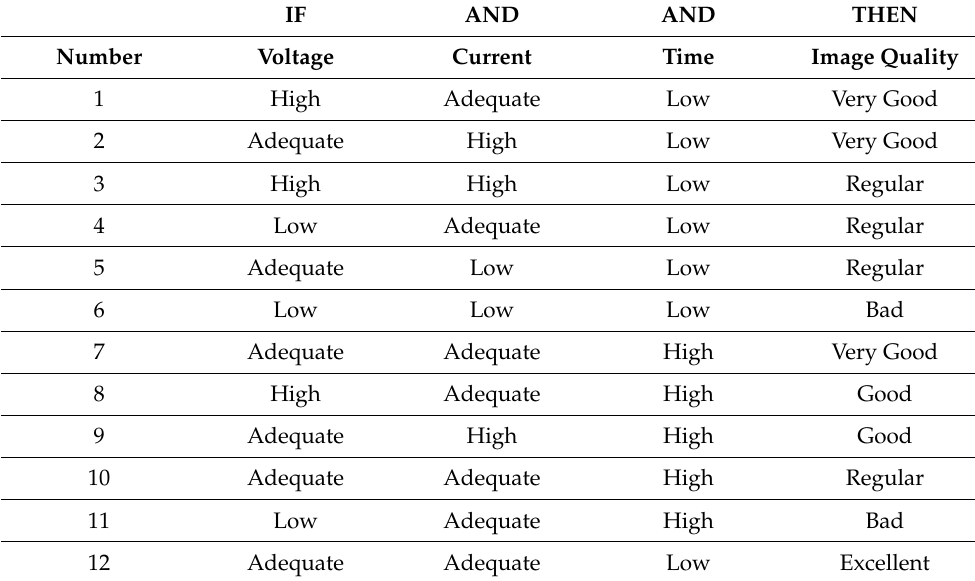
Table 1. Rules of the IT3IFS for